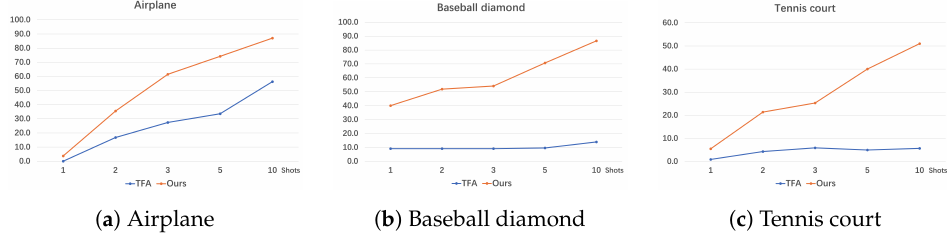
Figure 16. Precision of few-shot detection on each novel class in NWPU VHR-10.